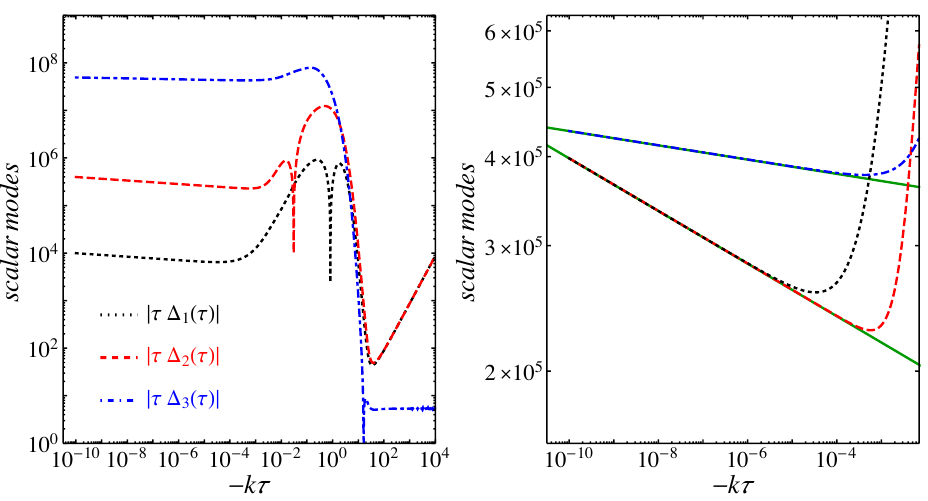
Figure 4 . Left: evolution of scalar (cid:13)uctuations in Higgsed Gauge-(cid:13)ation for (cid:15) = 0 : 01, (cid:13) = 3 and M = 5. Right: a zoomed region of the left panel with the modes rescaled according to eq. (3.51) . The green solid line corresponds to the analytically calculated growth rate for these parameters. The black-dotted and blue-dot-dashed curves have been vertically shifted, in order to align at late times with the red curve and (cid:12)t in a single